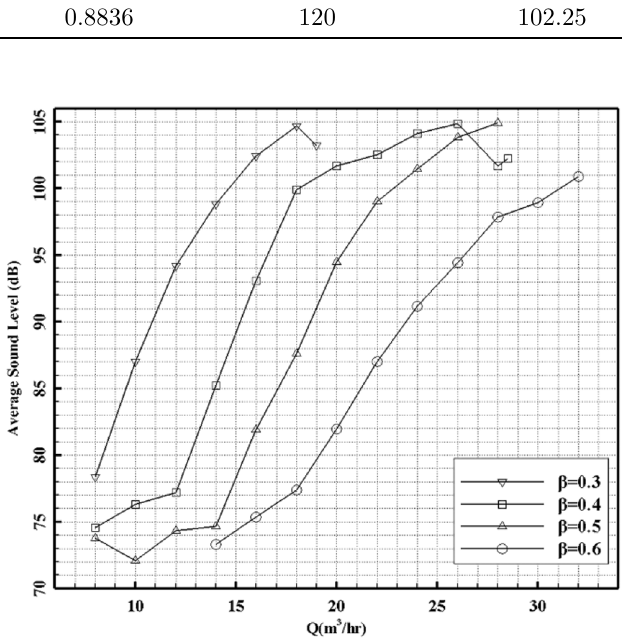
Fig. 5. Comparison of the ASL diagram with the fl ow rate change for different ori fi